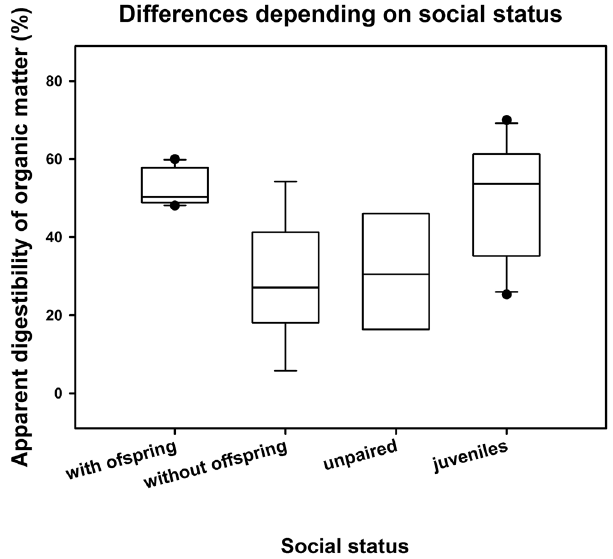
Figure 1. Differences in percentages of ‘apparent digestibility of organic matter’ (ADOM) between different social categories (i.e. paired with and without offspring, unpaired and juvenile individuals). Circles indicate outliers per group; error bars are based on interquartile ranges (lower: 25th and upper: 75th percentile).